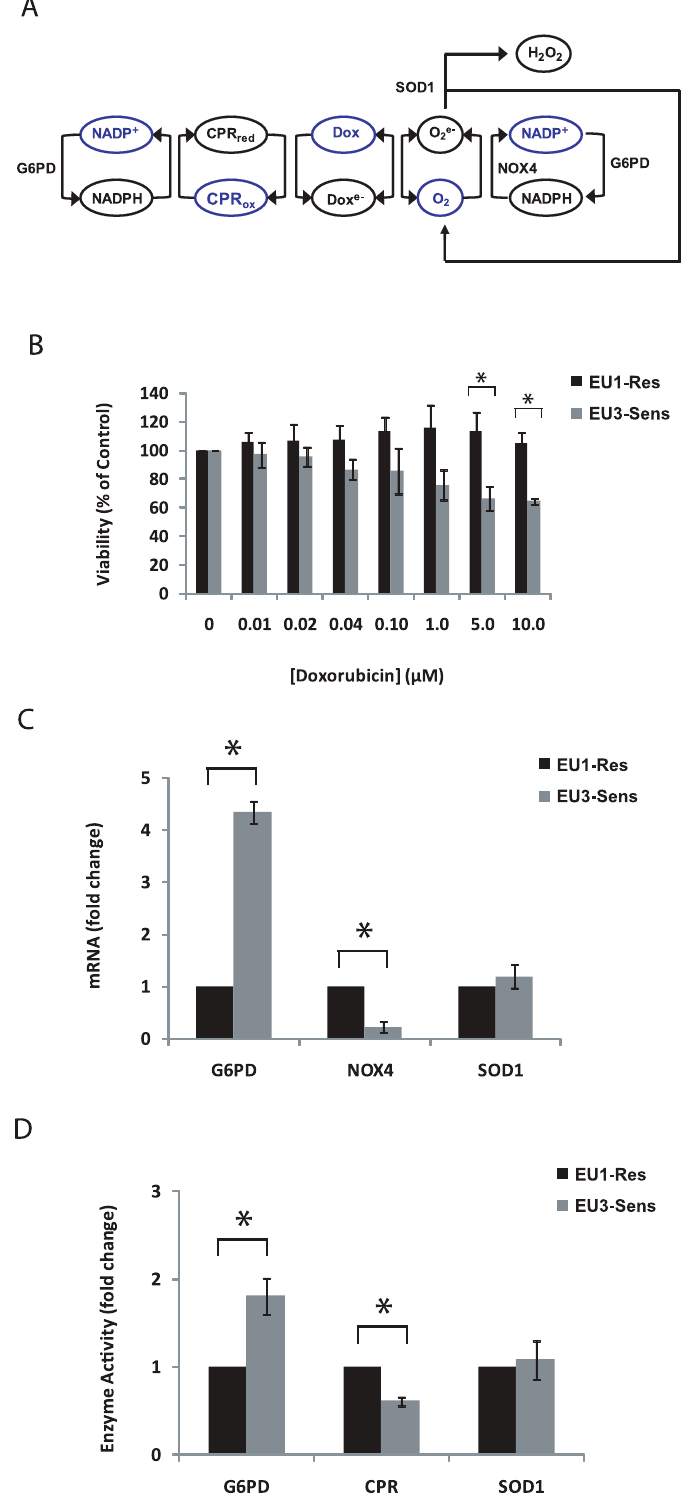
Figure 2. Doxorubicin sensitivity and bioactivation network components differ in EU1 and EU3 ALL cells. (A) Scheme describing in vivo doxorubicin bioactivation. (B) Cell viability for EU1-Res and EU3-Sens cells, determined by WST1 assay, after 3 hr doxorubicin treatment at varied concentrations. (C–D) Relative mRNA levels and enzyme activities of enzymes involved in doxorubicin bioactivation in ALL cells. (*p , 0.05).